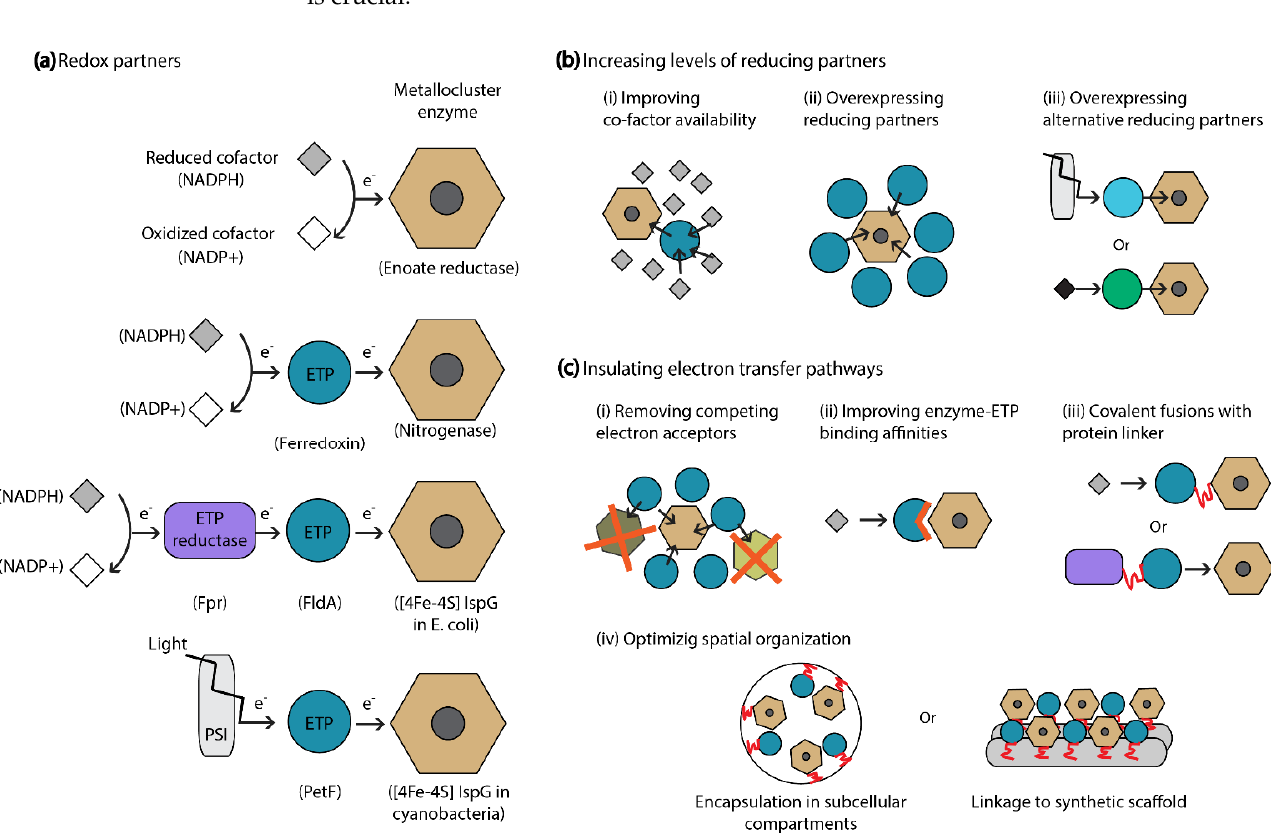
Figure 3. Strategies to enhance electron supply to redox active metallocluster enzymes. ( a ) Schematic representation of the diversity of electron transfer pathways coupled to the activity of different metallocluster enzymes. Most enzymes are coupled to one or multiple ETPs that shuttle electrons from cellular cofactors or photosynthetic chains (such as PSI). Examples of natural redox partners involved in each pathway are given in parenthesis. ( b ) Increasing levels of natural or alternative reducing partners is a successful strategy to enhance electron supply to a given metallocluster enzyme. ( c ) Strategies to insulate electron transfer pathways can be employed to optimize and direct electron flow.